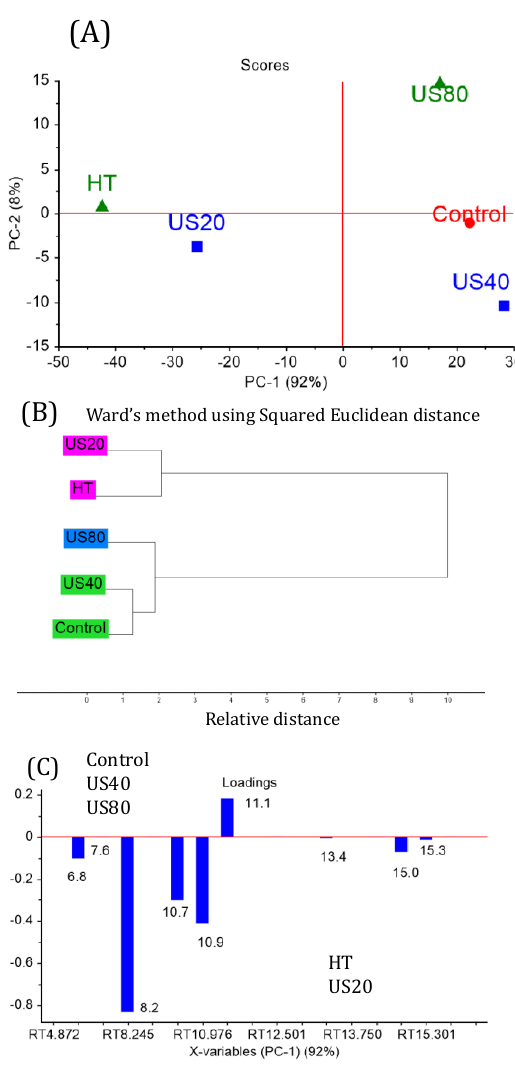
Figure 2. ( A ) Principal Component Analysis (Mean centered; Algorithm used: SVD Validation method: Cross validation: Full with 5 segments); ( B ) Cluster analysis: Method: Ward’s method; Distance: Squared Euclidean distance; Matrix Size: 5 samples, 31 variables. ( C ) Loadings (retention time (RT) of molecules with higher importance in each group).